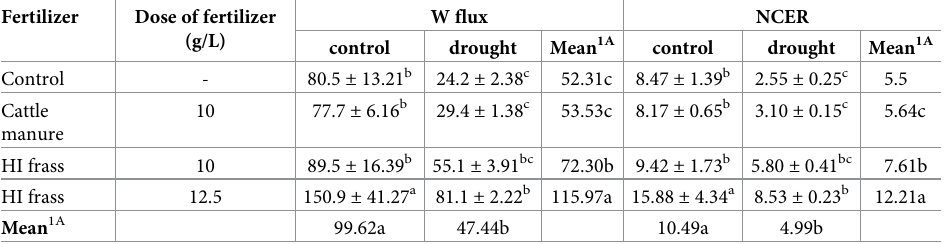
Table 3. Soil respiration in basil cultivated under drought stress, depending on the fertilizer used.